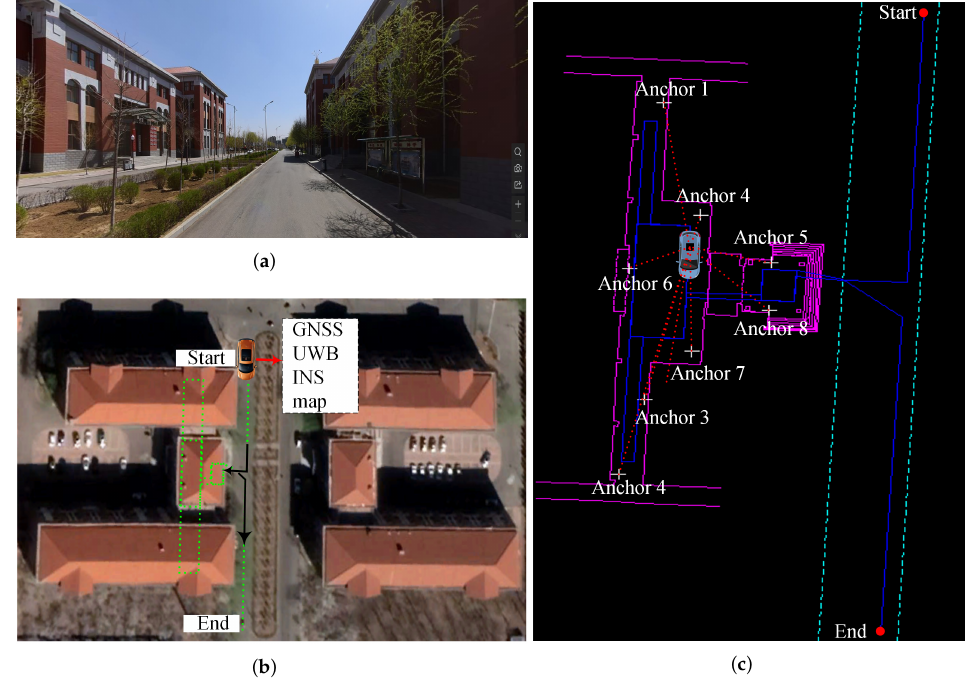
Figure 4. Experimental scene and design. ( a ) Experimental environment. ( b ) Top view of the experi- mental scene and the designed trajectory. ( c ) Experimental layout and established